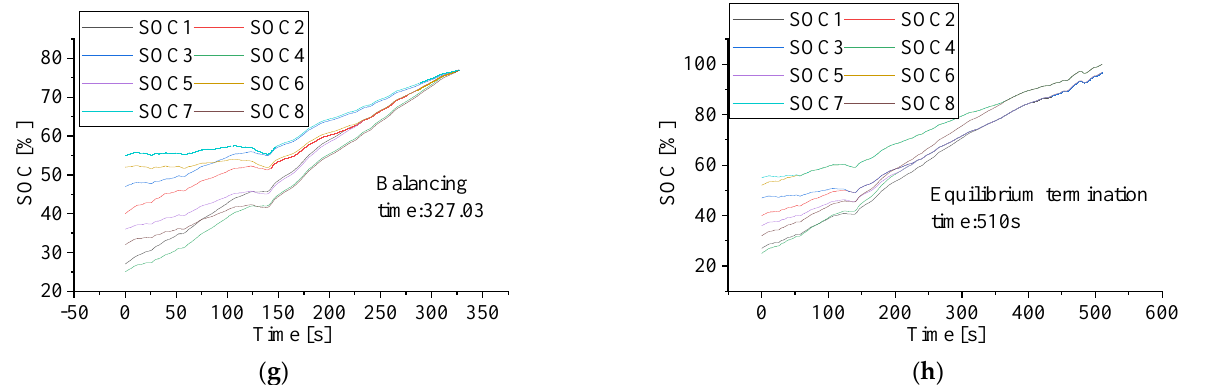
Figure 19. ( a ) case l multi-layer equilibrium, ( b ) case 1 adjacent equilibrium, ( c ) case 2 multi-layer equilibrium, ( d ) case 2 adjacent equilibrium, ( e ) case 3 multi-layer equilibrium, ( f ) case 3 adjacent equilibrium, ( g ) case 4 multi-layer equilibrium, ( h ) case 4 adjacent equilibrium.